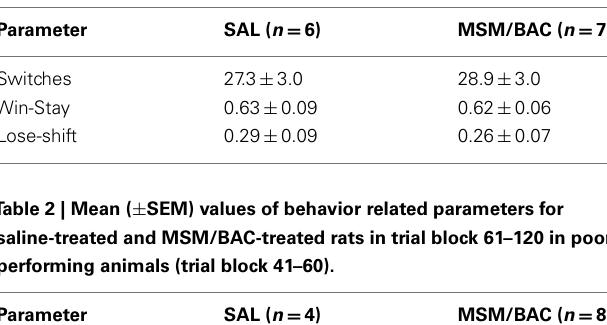
FIGURE 3 | Effects of injections of MSM/BAC or saline into the mPFC on r-IGT performance for the disadvantageous choices (A,B) and empty arm choices (C,D). Shown are means ± SEMs of per cent change from base-line